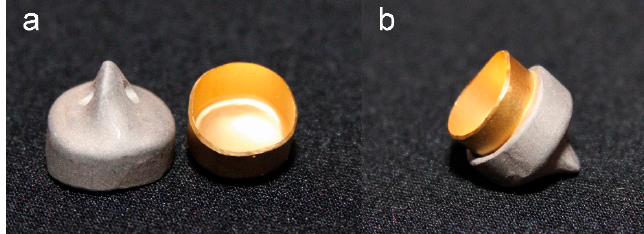
Figure 4. Electroformed gold coping and CoCr tertiary structure, separate ( a ); and assembled ( b